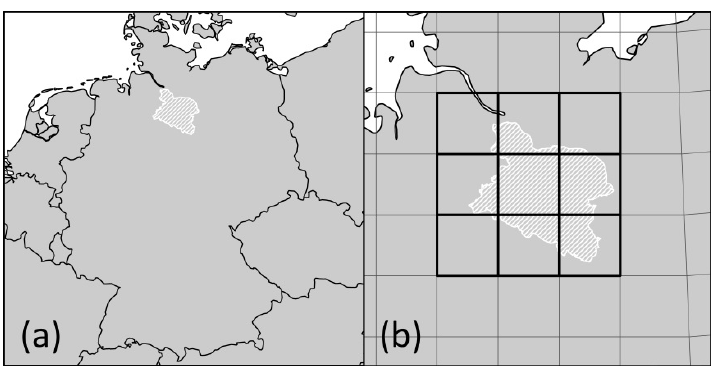
Figure 1. ( a ) Location of the natural landscape unit Lüneburg Heath within Germany (white shaded); ( b ) European Ornithological Atlas (EOA) grid cells that intersect the natural landscape unit Lüneburg Heath (bold